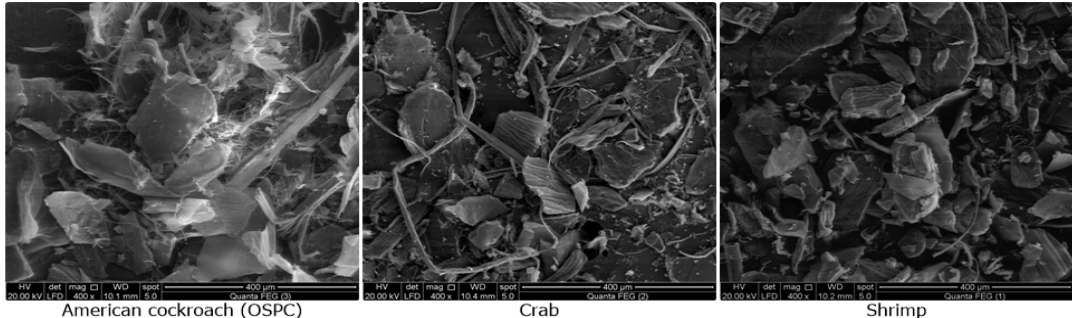
Figure 3. Scanning electron microscopy (SEM) pictures of the three chitin samples, the general theme revealed chitin flakes and microfibers in the three samples with much-isolated fibers observed for the OSPC.